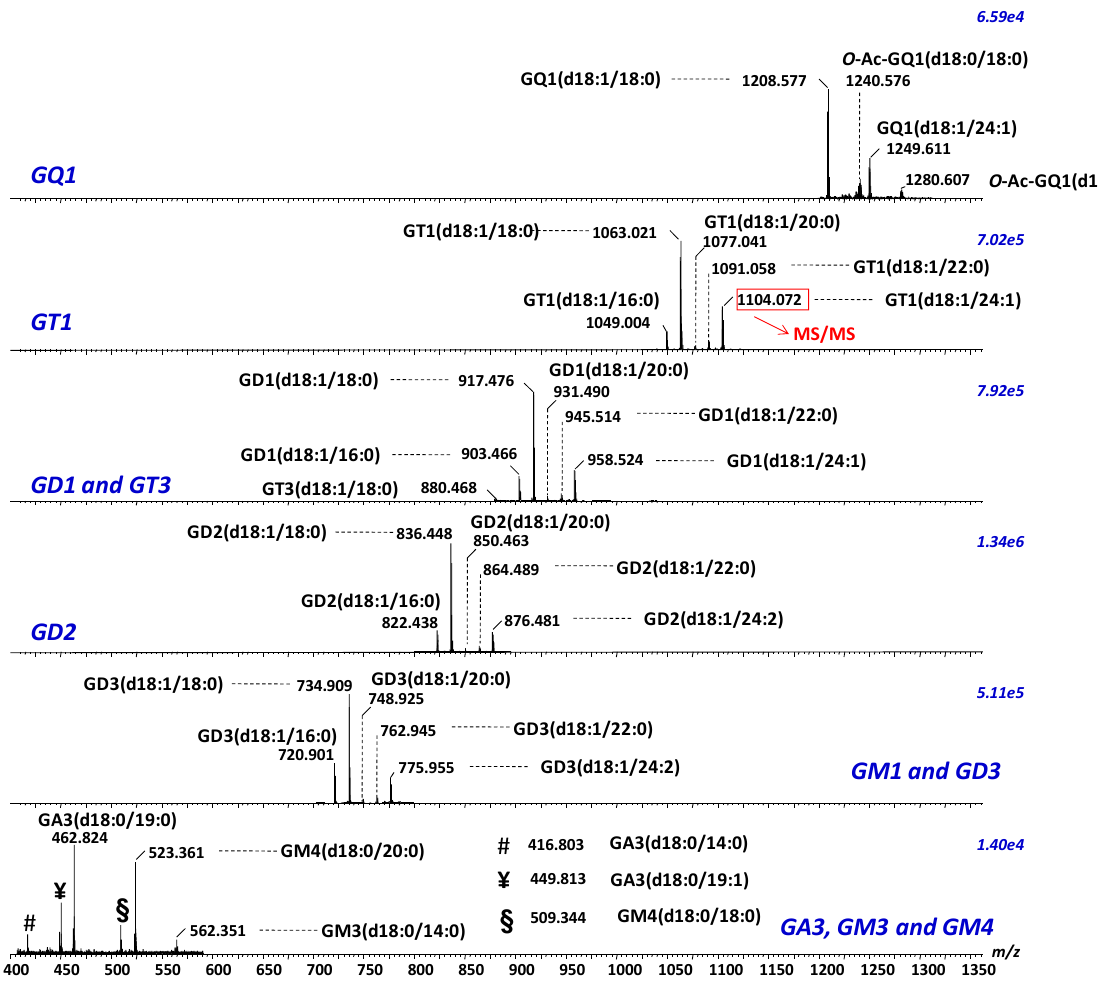
Figure 7. Extracted ( ‐ )nanoESI IMS mass spectra of doubly charged GA3, GM3 and GM4; GM1 and GD3; GD2; GD1 and GT3; GT1 and GQ1 from the corresponding areas indicated in Figure 6 (re ‐ printed with permission from [183]).